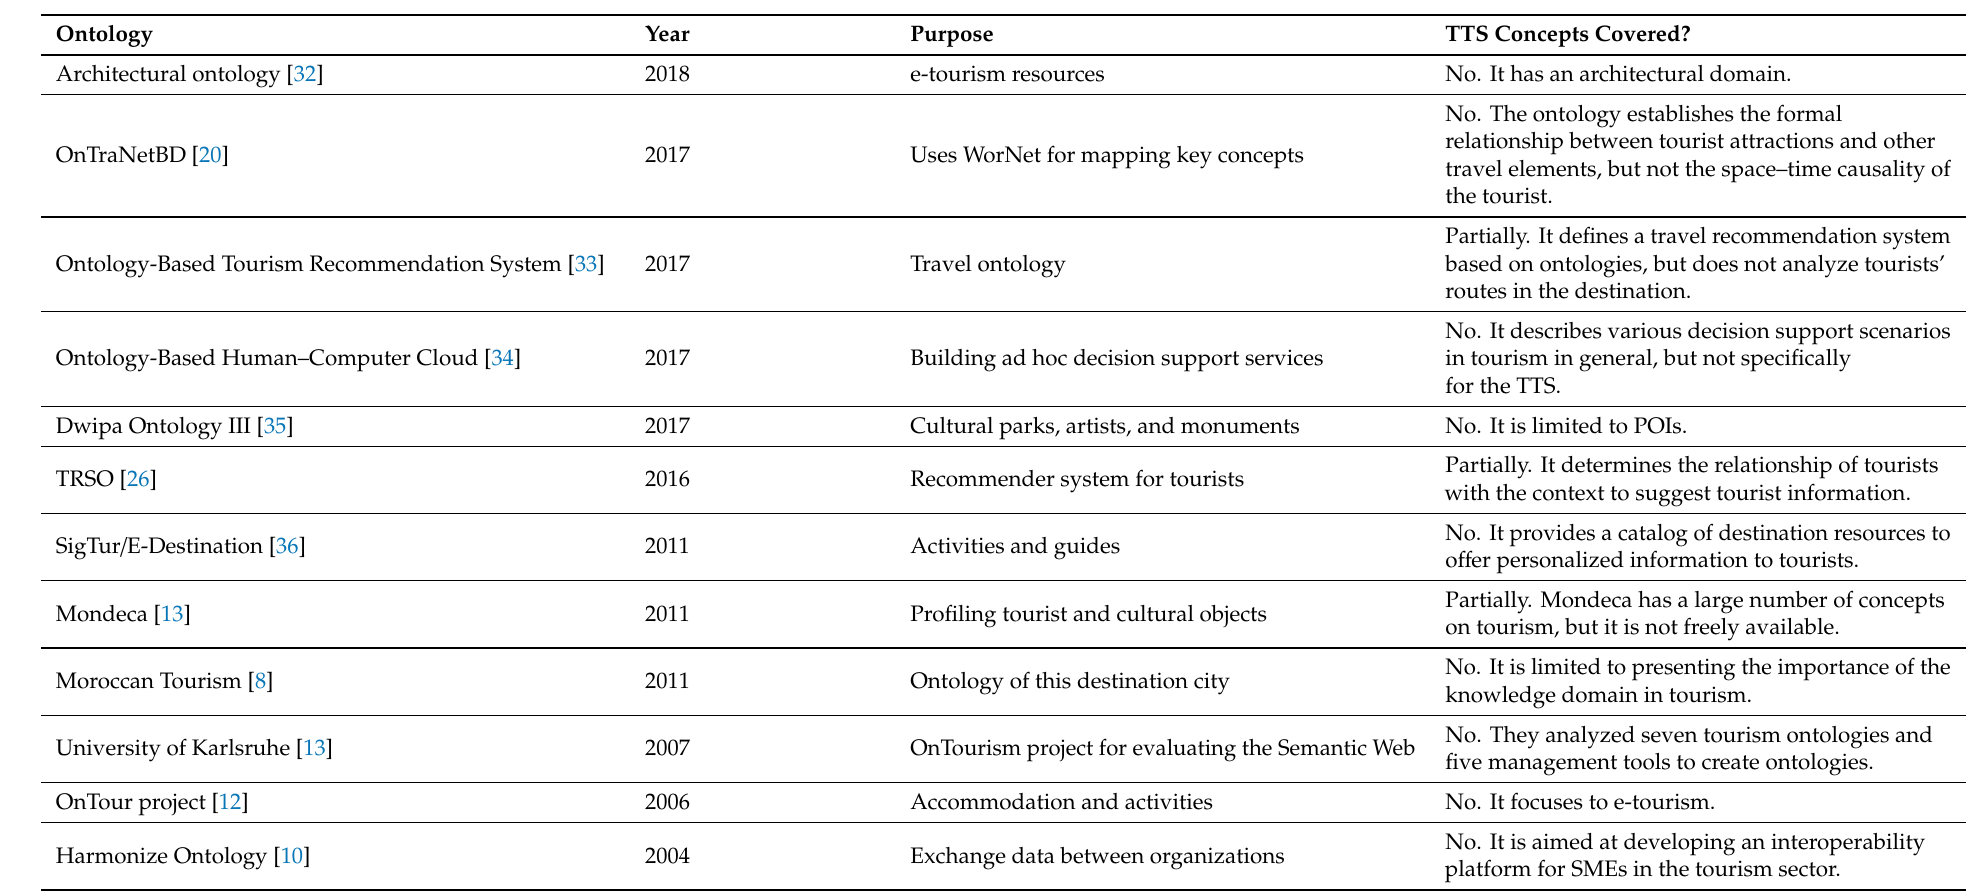
Table 1. Tourism domain ontologies found in the literature